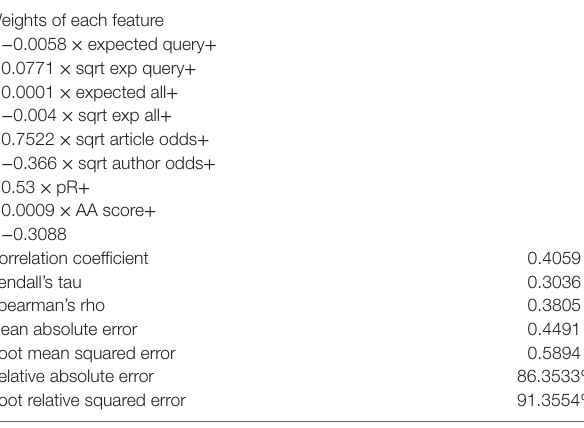
TaBle 7 | Multiple linear regression to predict the number of gap-filling articles appearing in the second time slice in the 10 biological processes queries